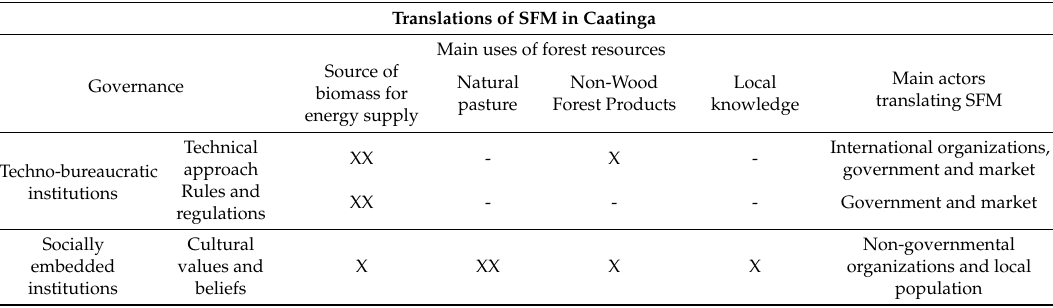
Table 2. Translations of SFM in